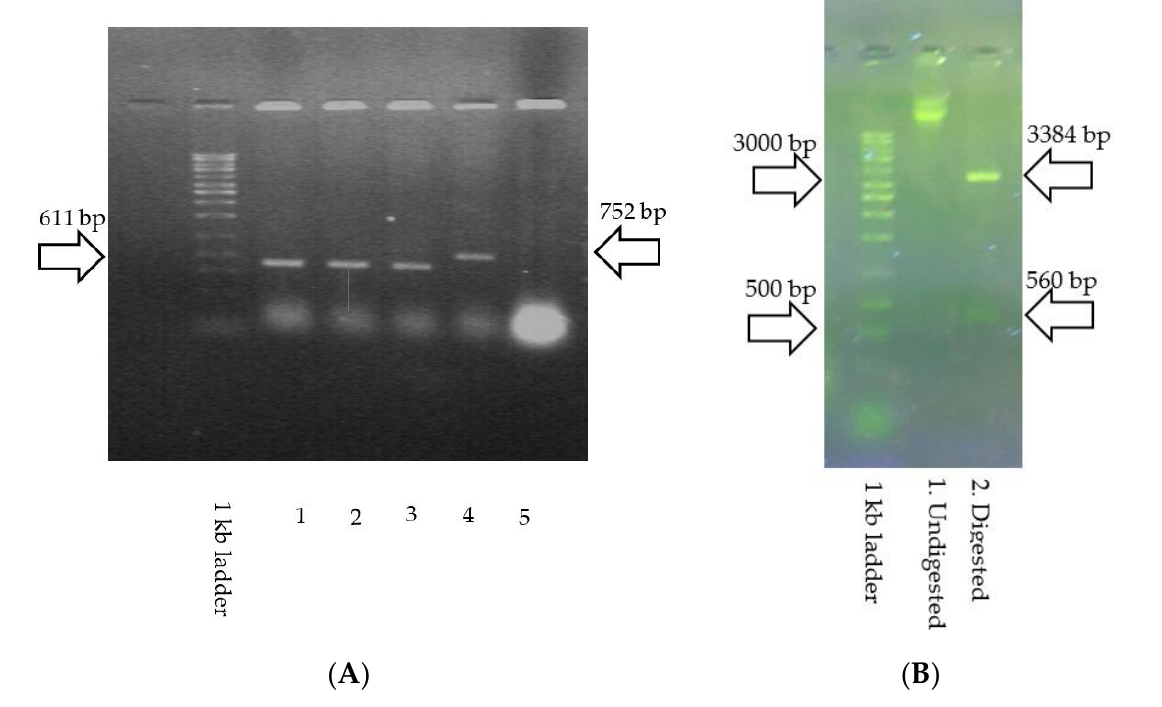
Figure 3. Construction of the pAK8-P1 phagemid. ( A ): Colony PCR with universal M13 primers: A 611 bp product is amplified in bacteria transformed with pAK8-P1 phagemid (lanes 1 to 3). Colony PCR on bacteria containing the pAK8 phagemid with unrelated inserts resulted in a 752 bp product (positive control for M13 phagemid, lane 4), and no amplification was observed in non-transformed bacteria (negative control, lane 5). ( B ): Restriction site mapping: Undigested phagemid was seen in lane 1. Digestion of pAK8 phagemid with EcoRI and HindIII resulted in 2560- and 3384-nucleotide DNA fragments, indicating the P1 gene’s insertion into the pAK8 phagemid, according to SnapGene analysis.